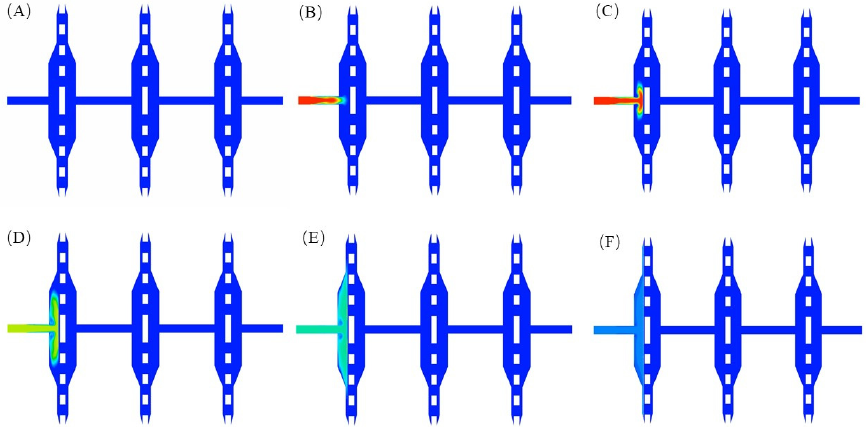
Figure 7. Volume fraction cloud images of 4 μ m particles at different times: ( A ) t = 0 s; ( B ) t = 0.5 s; ( C ) t = 1 s; ( D ) t = 1.5 s; ( E ) t = 2 s; ( F ) t = 2.5 s.